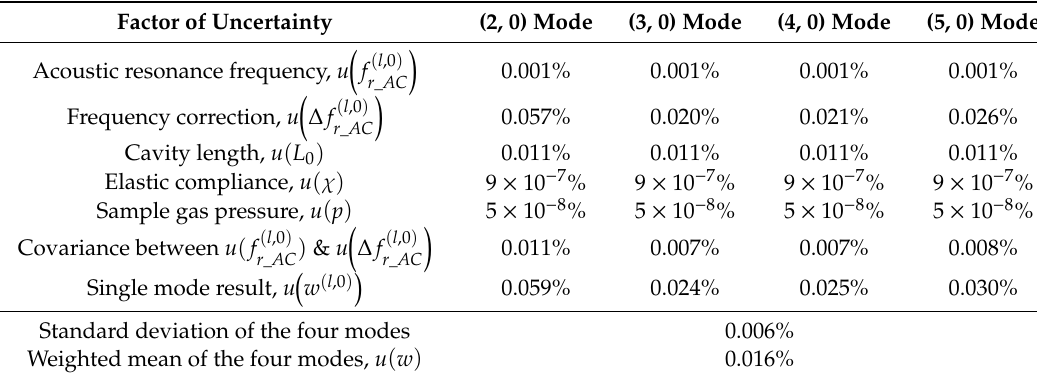
Table 1. Uncertainty budget for the sound velocity measurement at 343 K and 150